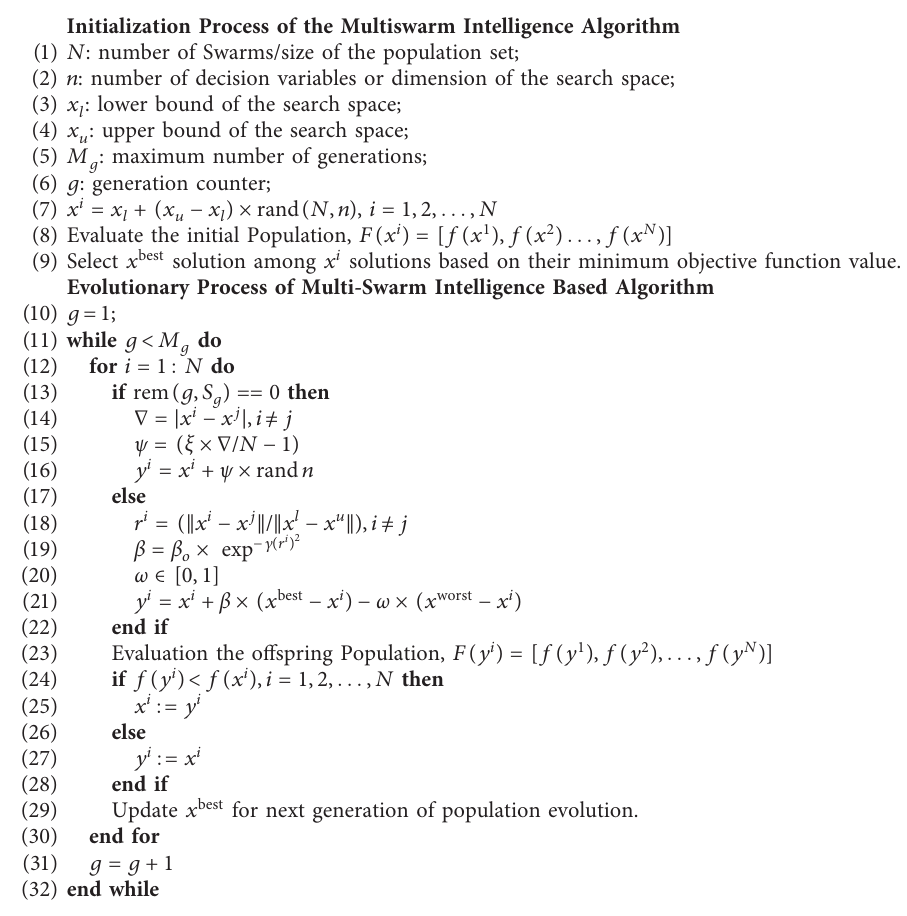
Initialization Process of the Multiswarm Intelligence